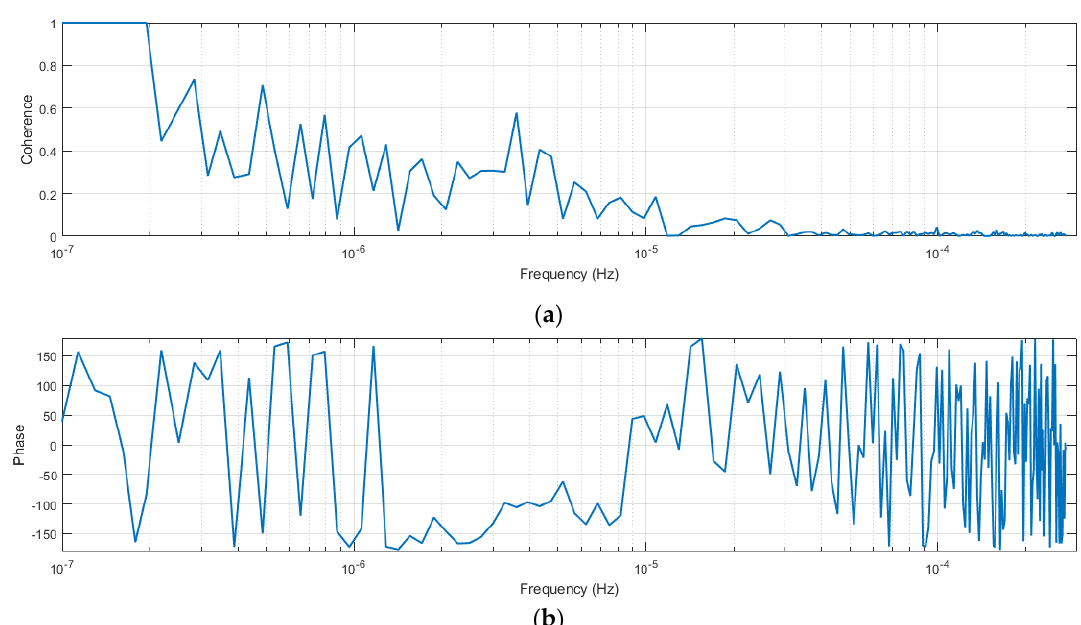
Figure 13. Cross spectrum of low ‐ frequency sea ‐ level records and MSLP at Bushehr station ( a ) coherence ( b ) phase difference.